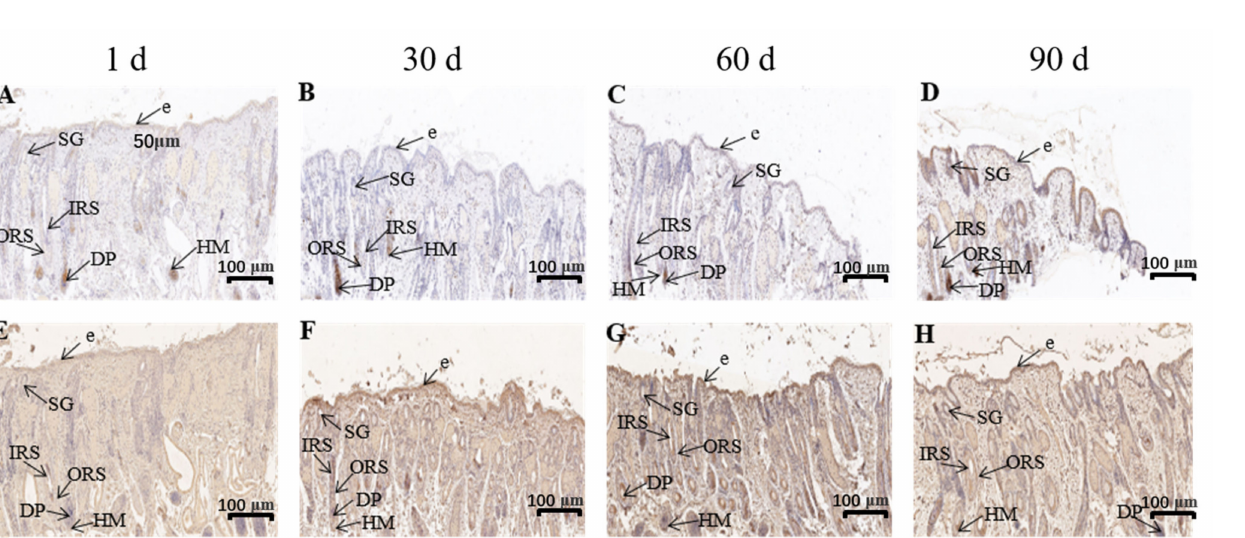
Figure 4. Immunohistochemical staining (10 × ) of skin tissues of Gansu Alpine Merino at various ages. ( A – D ) Lef1 skin tissue distribution at various ages; ( E – H ) Dlx3 skin tissue distribution at